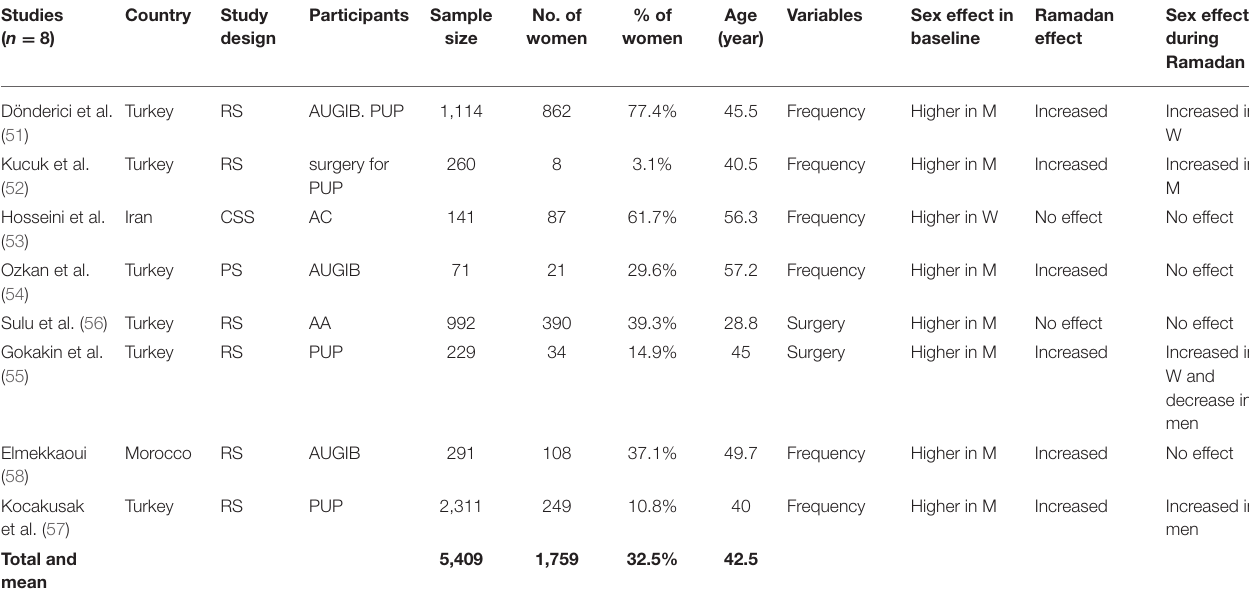
TABLE 6 | Sex differences in outcomes related to gastrointestinal diseases in patients during and outside the month of Ramadan. Studies ( n = 8)